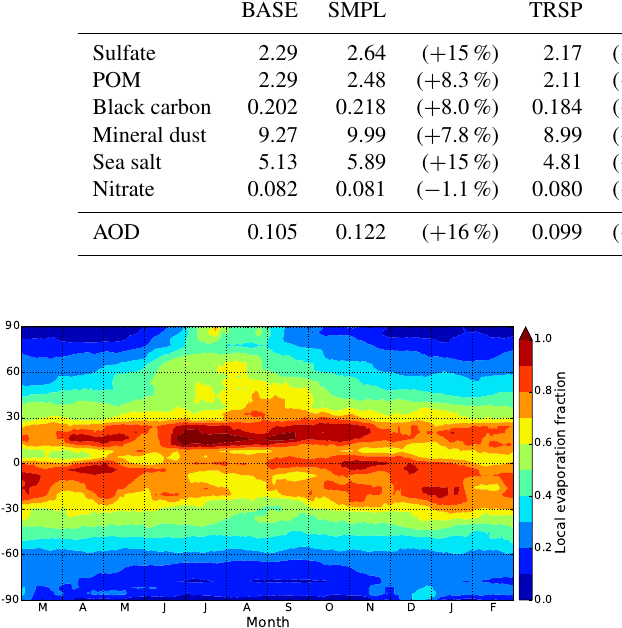
Figure 6. Column total, zonally averaged evaporation expressed as a fraction of local precipitation formation for March 2005 to Febru- ary 2006. Values shown are smoothed by a 30-day running